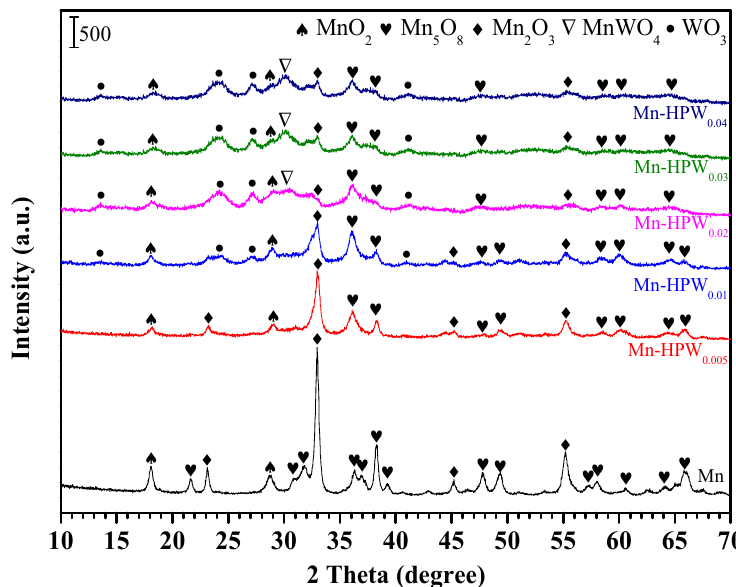
Figure 1. XRD patterns of Mn and Mn-HPW x .